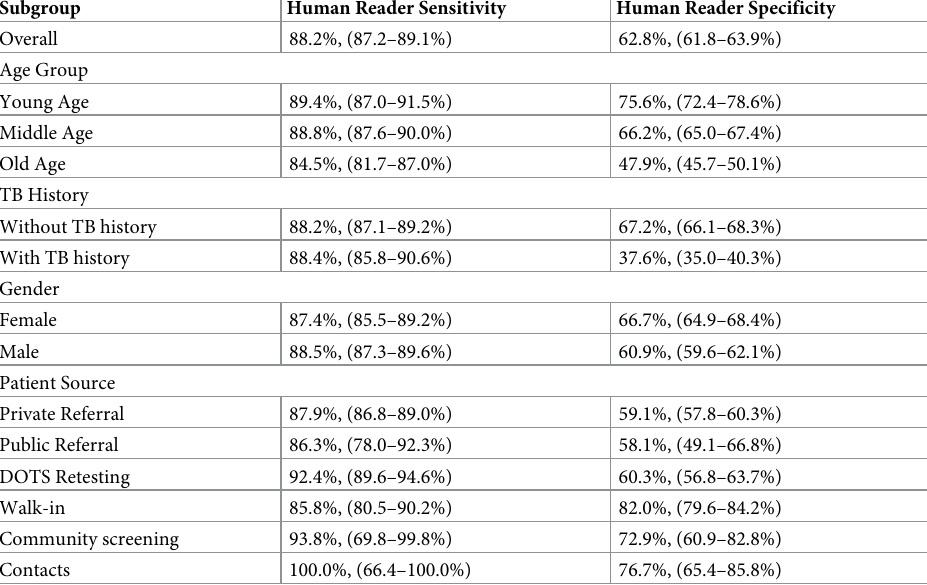
Table 4. The sensitivity and specificity of human readers in these